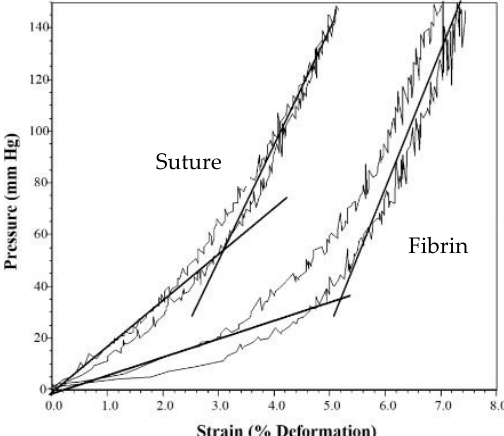
Figure 10. Representative graphs of the stiffness of the treated graft vs. the sutured control [56]. Table 1. Elastic modulus mation was able to be obtained in the animal model. This was helpful in a better quantifi- cation of the change in stiffness between treatments. Table 1 shows the elastic modulus of the healed meshed skin grafts after 3 and 10 days. There were six treatments: fibrin with- out FGF (F), fibrin with FGF (FW), porous fibrin without FGF (PF), porous fibrin with FGF (PFW), sutured control (S), and normal skin (NL). The stiffness was measured in a tensile test on excised wounds of the meshed skin grafts. The ones comparable to Figure 10 (clin- ical study) are F (fibrin), FW (fibrin with FGF-1), and S (sutured control). Additionally